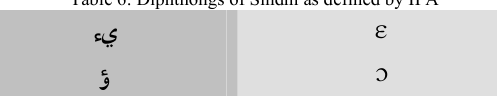
Table 7: Examples of IPA symbols for Sindhi vowels and diphthongs IPA Sindhi Example IPA Symbol Vowel Word Transcription